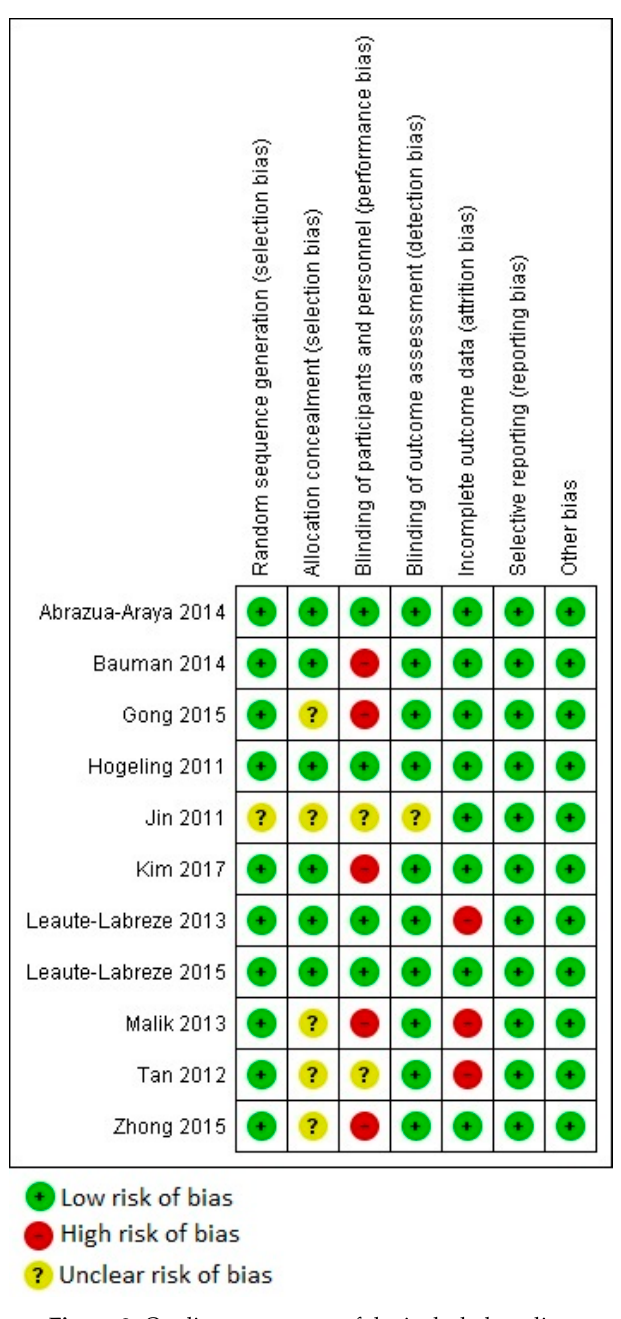
Figure 2. Quality assessment of the included studies.